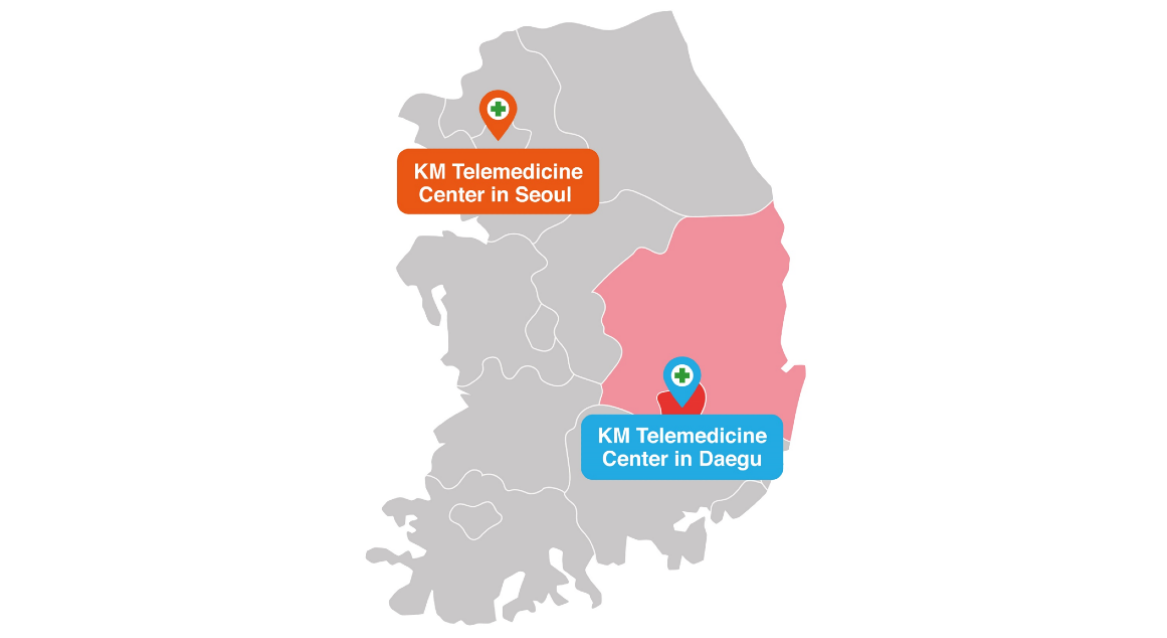
Figure 1. Locations of the COVID-19 telemedicine centers of Korean Medicine. KM: Korean